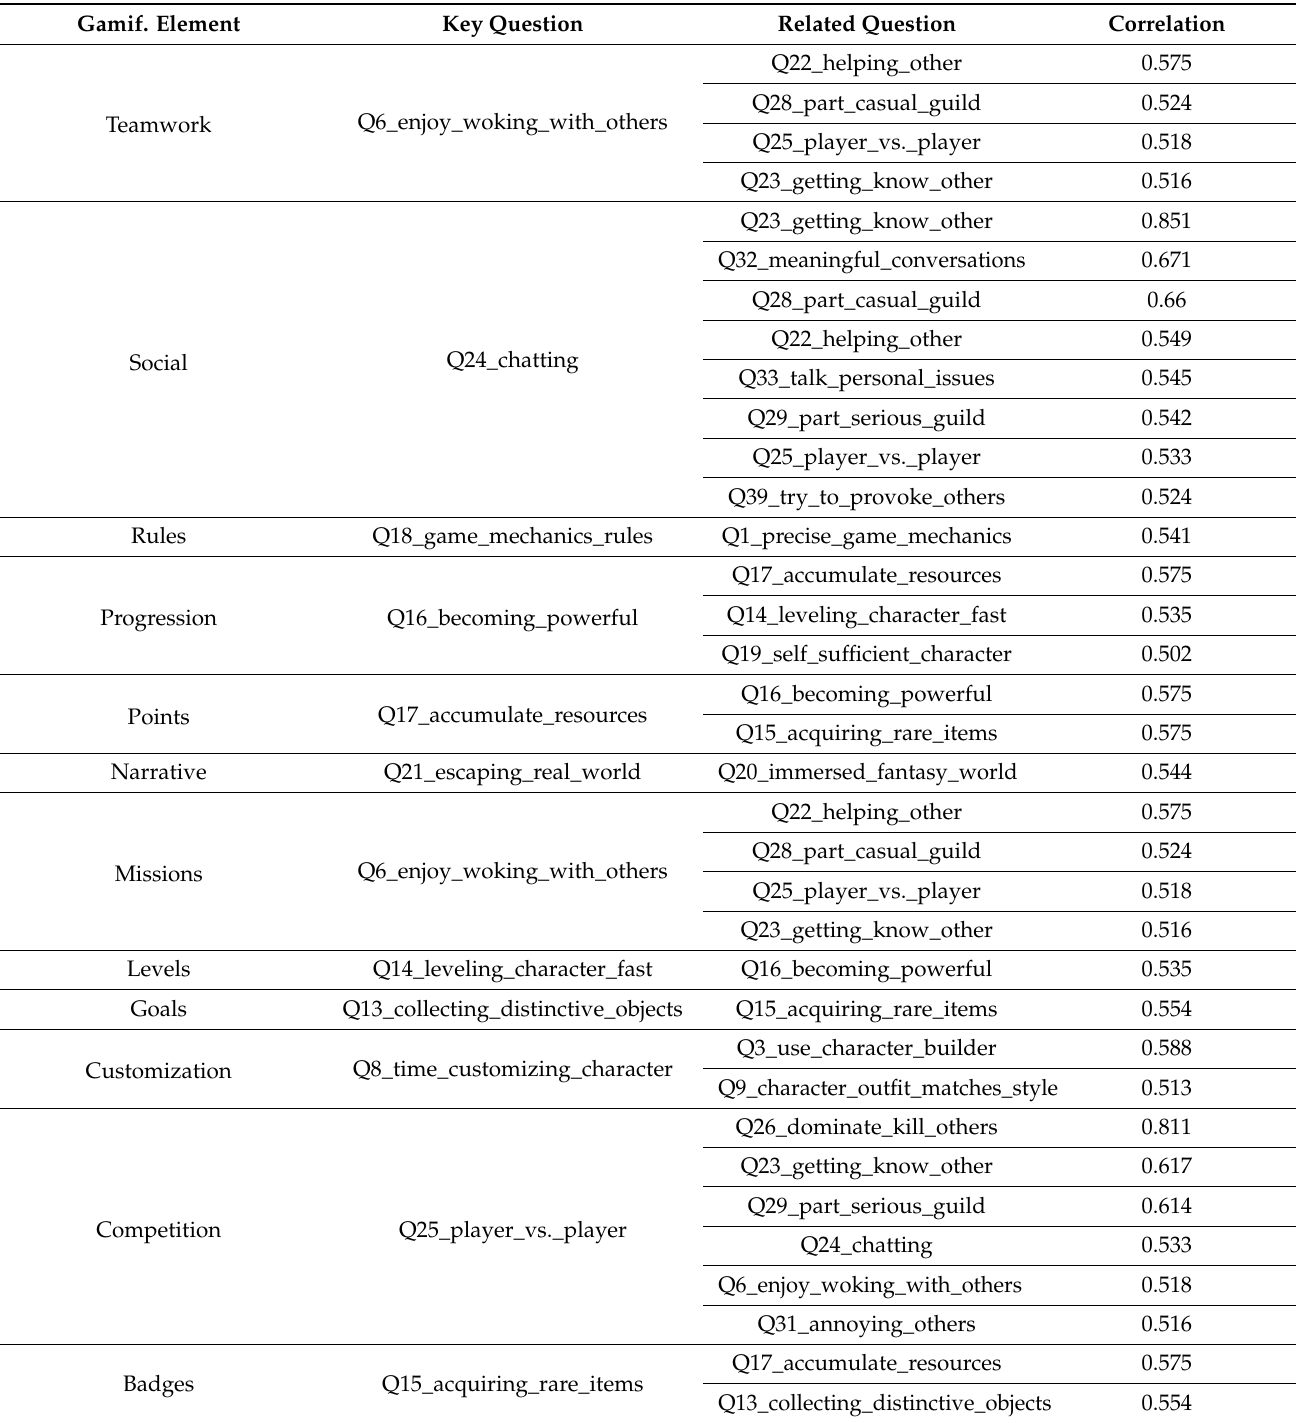
Table 2. Relation of gamification element with the key question and questions with a correlation factor greater than